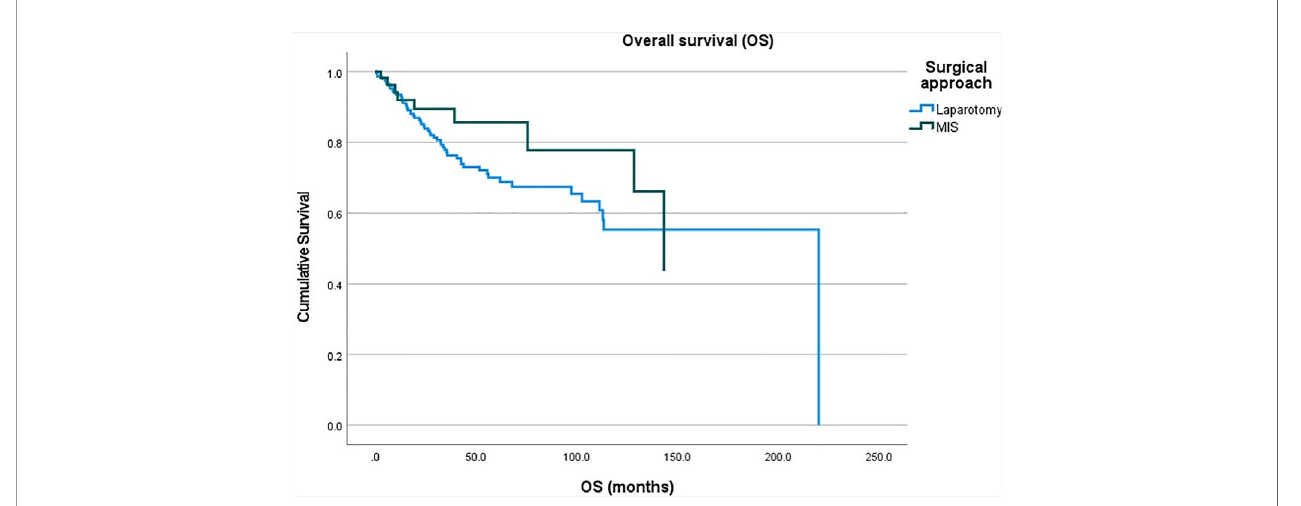
FIGURE 3 | Overall survival of the patients with endometrial cancer between the minimally-invasive surgery (MIS) group vs . laparotomy group.